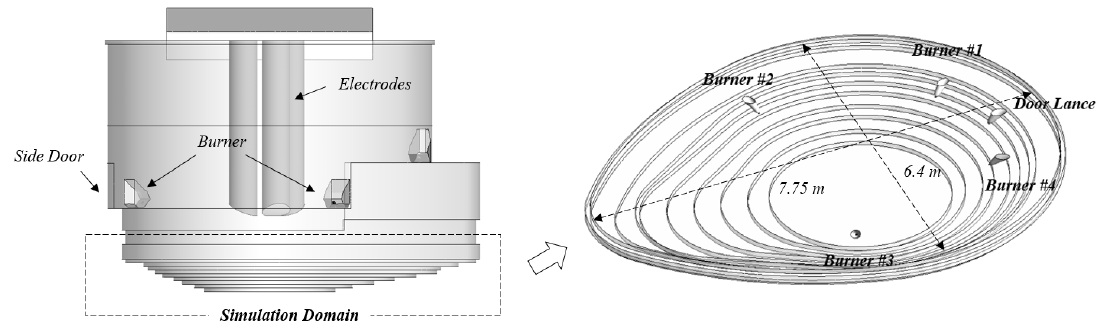
Figure 4. 3D computational domain with jet penetration cavities for decarburization modeling.